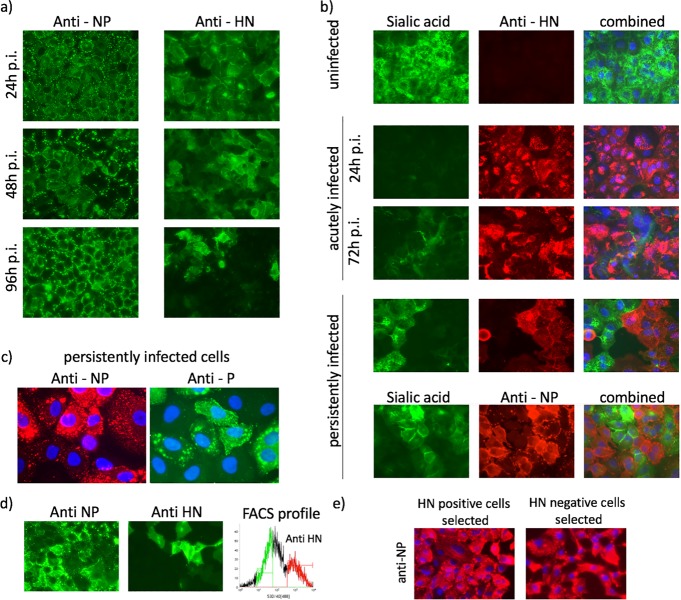
PIV5 fluxes between active and repressed states in persistently infected cells.Panel a) A549 cells grown on coverslips were infected with PIV5 W3 at 10 pfu per cell. At the indicated times p.i. the cells were fixed, permeabilized and stained with anti-NP and anti-HN monoclonal antibodies. Panel b) uninfected A549 cells or cells infected with PIV5 at 10 pfu/cell were fixed at 24 and 72h p.i. then stained for surface expression of sialic acid, or immunostained with an anti-HN monoclonal antibody. In addition, cells that were persistently infected with PIV5 (passage 3) were similarly stained, as well as being stained with an anti-NP monoclonal antibody. The nuclei were also visualised by staining the cells with DAPI (blue). Panel c) PIV5 (passage 3) persistently infected cells were immuostained with an anti-NP or anti-P mAb; the cells nuclei were also visualised by staining the cells with DAPI (blue). Note, some cells are strongly positive for NP or P, whilst others are only weakly positive. Panel d). A549 cells persistently infected with PIV5 W3 (p3) were fixed and immunostained for NP and HN and at the same time live cells were also immunostained for surface HN and the relative levels of HN expression measured by FACS analysis. Both HN-positive (red) and HN-negative (green) populations were separated as single cells into 96-well plates and colonies grown for 2 weeks in the presence of a pool of neutralizing monoclonal antibodies. Panel e) Examples of colonies of cells, derived from cells that had been FAC-sorted on the basis of whether they were or were not positive for HN, that were grown in 96-well plates were fixed and immunostained with anti-NP mAb, and counter-stained with DAPI. Cells were visualized using an EVOS microscope.